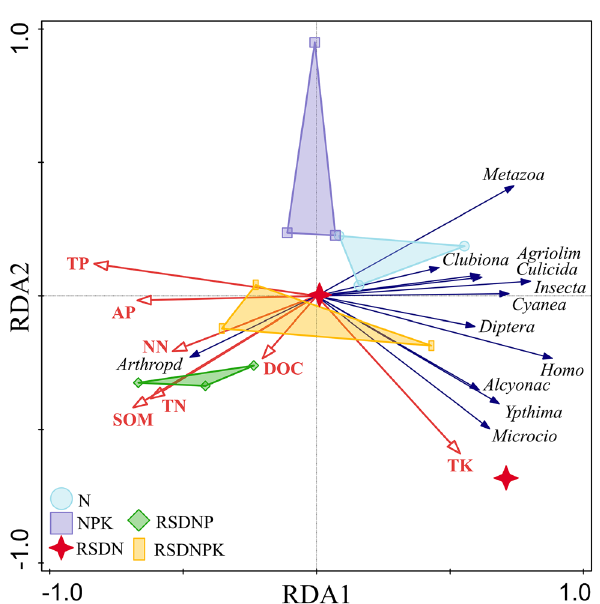
Figure 5. Redundancy analysis of the top 40 abundant taxa of soil fauna with selected soil physical and chemical properties. Arthropd: p_Arthropoda; Insecta: c_Insecta; Alcyonac: o_Alcyonacea; Agriolim: f_Agriolimacidae; Culicida: f_Culicidae; Microcio: f_Microcionidae; Coenobit : g _Coenobita ; Clubiona : g_ Clubiona ; Diptera : g _Diptera ; Cyanea : g_ Cyanea ; Ypthima : g _Ypthima ; Homo : g_ Homo . N synthetic N fertilizer, NPK synthetic fertilizer: nitrogen, phosphorus and potassium, RSDN crop residues returned with nitrogen, RSDNP crop residues returned with nitrogen and phosphorus, RSDNPK crop residues returned with nitrogen, phosphorus and potassium, SOM soil organic matter, TN total nitrogen, TP total phosphorus, TK total potassium, AP available phosphorus, DOC dissolved organic carbon, NN nitrate